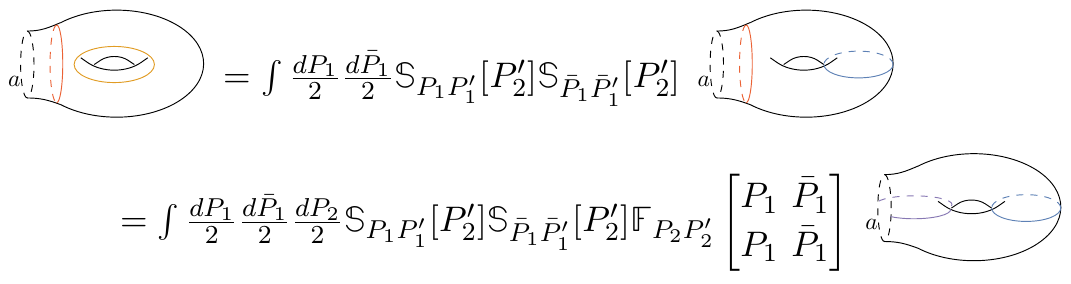
Figure 4 . The decomposition of the“ tadpole” channel conformal block in terms of “OC-loop” channel conformal blocks for the genus-one surface with a conformal boundary labelled by a : first we interchange cycles on the torus with an S-transformation, and then we change to the dual channel of the resulting disk two-point function (of identical bulk operators, suitably summed over) with a holomorphic fusion